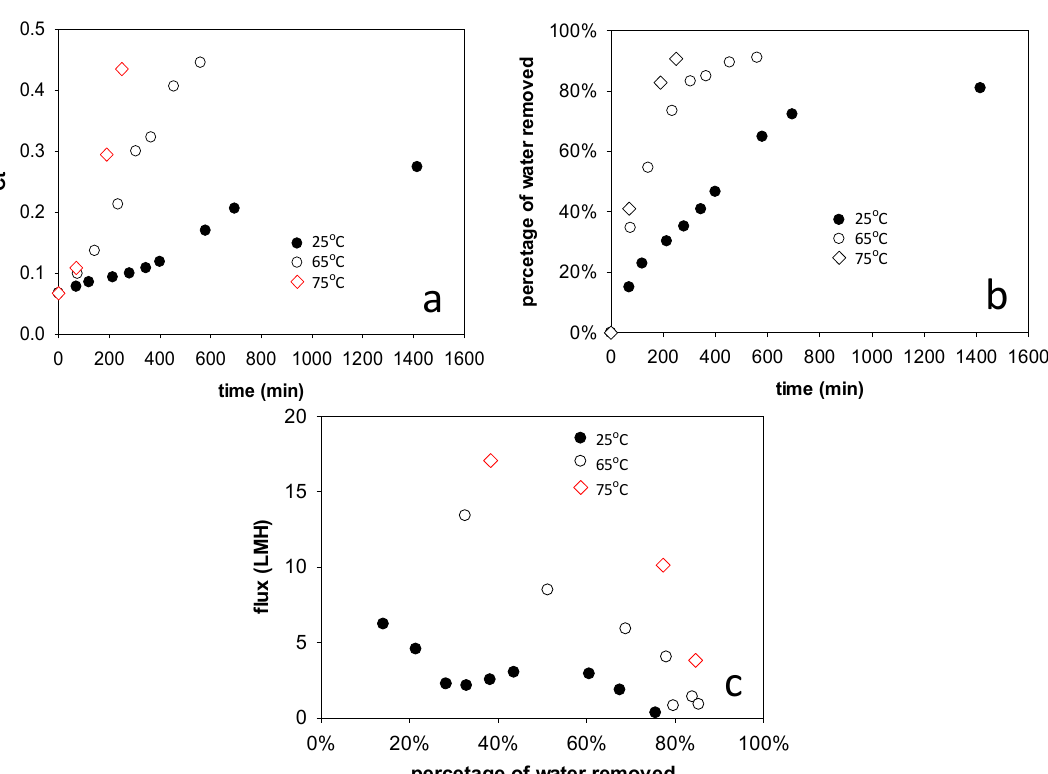
Table 1. Estimated minimum membrane area. 219